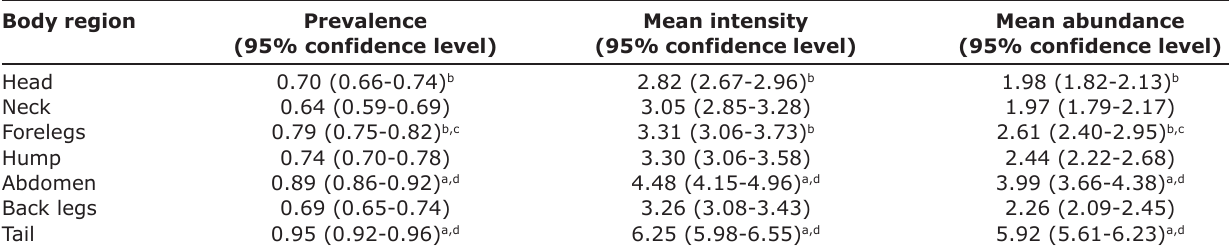
Table-2: Camel tick Hyalomma dromedarii prevalence, mean intensity, and mean abundance on examined animals. Body